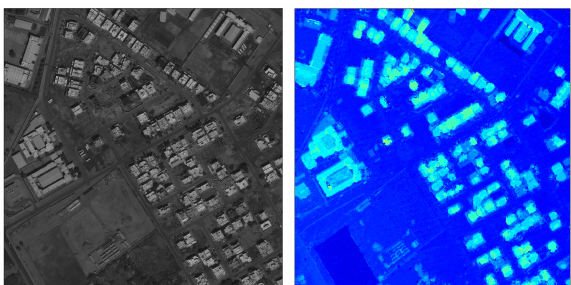
Figure 5: Left: Worldview-3 Image (Muscat, Oman) Right: DSM generated from